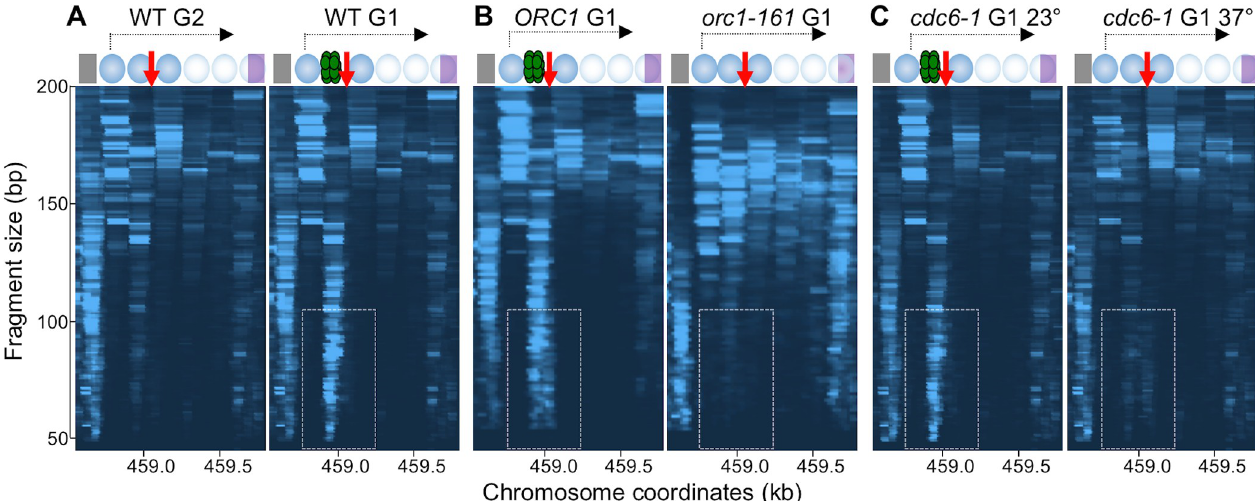
Fig 2. Pre-RC binding at rDNA origin is G1-specific and ORC1 - and CDC6 -dependent as determined by MNase-seq. Diagrams at the top of each panel denote a 1.25 kb region of the rDNA that includes the rDNA origin marked by a dashed line in Fig 1A. The gray rectangle on the left represents the Reb1 binding site (S1 Fig), blue circles represent nucleosomes with transparency level inversely related to their occupancy, the red vertical arrow shows the location of rARS, the green doublet represents the Mcm2-7 double hexamer, the purple rectangle represents the 5S RNA gene, and the black horizontal arrow represents the c-pro transcript. Genomic coordinates according to the sacCer3 genomic sequence are shown on the x axes, fragment length on the y axes and relative read depth is indicated by color intensity. Dashed rectangles point to the area that corresponds to the footprint of the Pre-RC complex. A. Chromatin was isolated from cultures of a WT strain (16535) arrested in G2 with nocodazole or in G1 with alpha factor, treated with MNase to digest DNA not protected by bound proteins and subjected to paired end sequencing. Plot shows genomic coordinate on the X axis, fragment size on the Y axis, and relative read depth indicated by color intensity. B. The analysis of previously published orc1-161 MNase-seq data set [23]. orc1-161 cells were arrested in G1 at the restrictive temperature and compared to ORC1 cells. C. cdc6-1 (16738) cells were arrested in G1 at permissive (23˚C; left) or restrictive (37˚C; right) temperature and processed as in A.